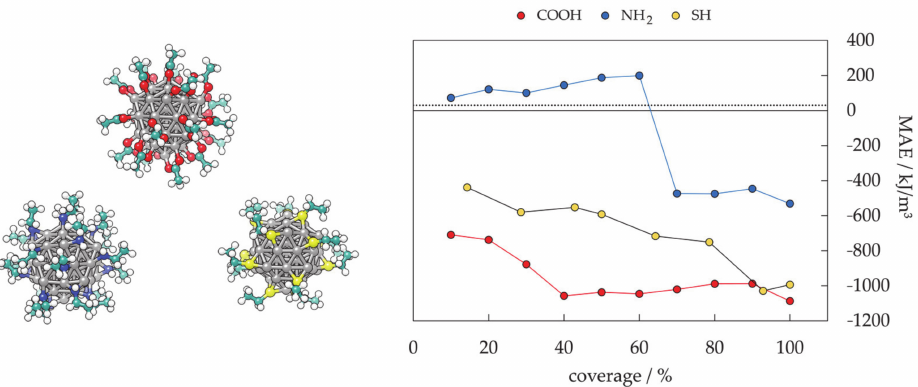
Figure 19. Structures ( left ) and magnetic anisotropy energy, MAE, as a function of ligand coverage ( right ) of COOH-, NH 2 -, and SH-passivated 55-atom icosahedron Co mNPs. MAE of unpassivated 55-atom Co icosahedron is added as the dotted line. Data are taken from Farkaš (2021)